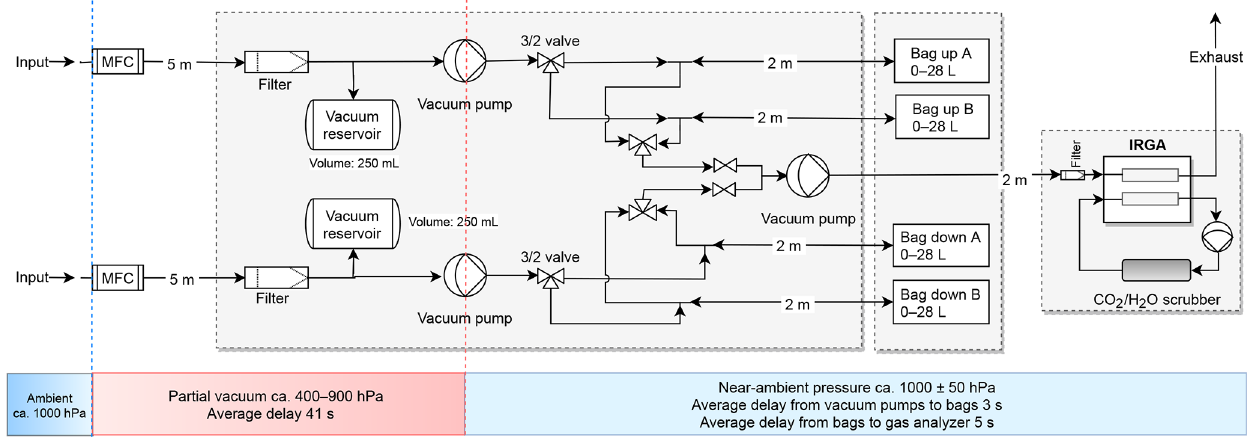
Figure 5. Hydraulic and functional schematic of the true eddy accumulation system with components layout, properties, and operating conditions. System components shown are the piping layout, mass flow controllers (MFCs), pumps, valves, filters, reservoirs, and the gas analyzer. Piping lengths and volume of air reservoirs are shown alongside the components. The operating pressure is shown for three distinct regions of the system below the system layout (colored bars) together with the average transit times of air through specific sections of the system. The air sampling bags are marked with “up” for collecting updrafts and “down” for collecting downdrafts. Bag sets A and B alternate their function (charge, discharge) every